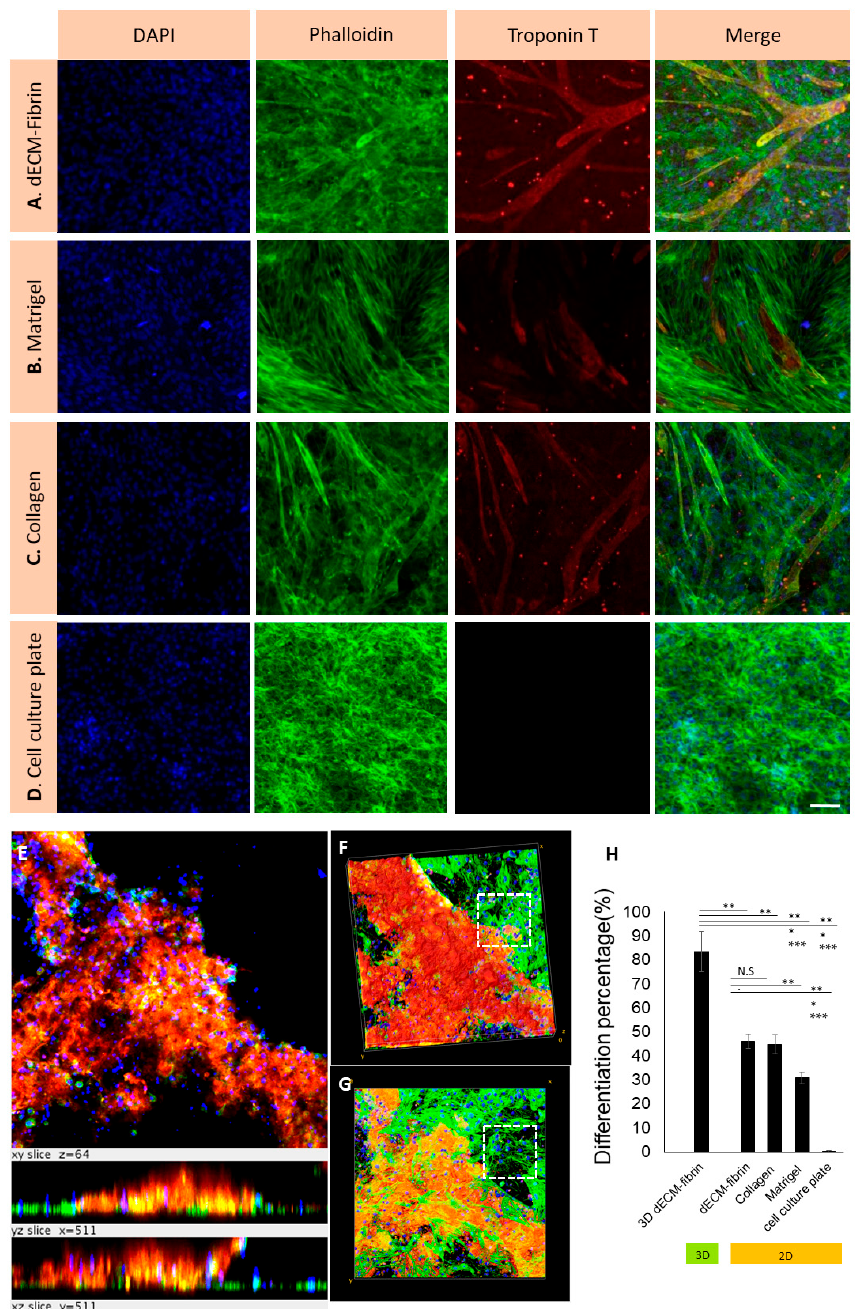
Figure 5. Expression of Troponin T in H9c2 cells in a co-culture with fibroblasts on different hydrogels (2D) and in the dECM-fibrin hydrogel (3D) in the absence of retinoic acid. Expression of Troponin T in dECM-fibrin ( A ), Matrigel ( B ), collagen I ( C ), and cell culture plates ( D ) after 7 days of differentiation is shown. Confocal images of H9c2 cell differentiation in a 3D co-culture featuring H9c2: fibroblasts in a 30%:70% ratio in dECM-fibrin hydrogel after 7 days is presented ( E ). Cells in dECM-fibrin hydrogel are shown: top view ( F ) and bottom view ( G ). Dashed white boxes in ( F , G ) confirm the absence of non-specific staining for Troponin T antibody ( H ) Percentage of Troponin T expressed H9c2 cells on different hydrogels in 2D and 3D is presented. Troponin T-specific staining (red) shows the differentiated cells. Phalloidin-specific staining (green) indicate the actin filaments of all cells. DAPI (blue) stains the nuclei. Scale bar: 100 µ m. The hydrogel boxes in ( E – G ) are 511 µ m by 511 µ m. ( p = 0.0024 for dECM-fibrin vs. Matrigel, p = 0.0001 for dECM-fibrin vs. cell culture plate, and p = 0.645 for dECM-fibrin vs. collagen.) N.S. = p > 0.05, * = p ≤ 0.05, ** = p ≤ 0.01, *** = p ≤